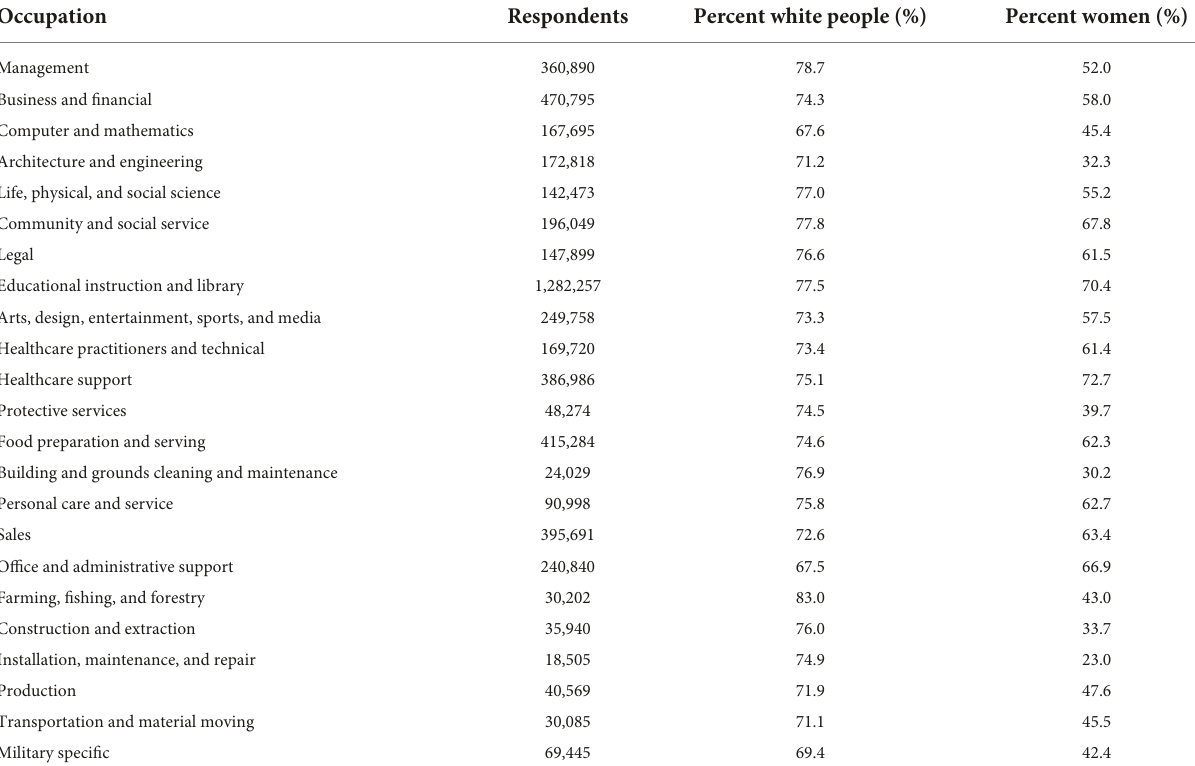
TABLE 1 Occupations, number of respondents, and participant